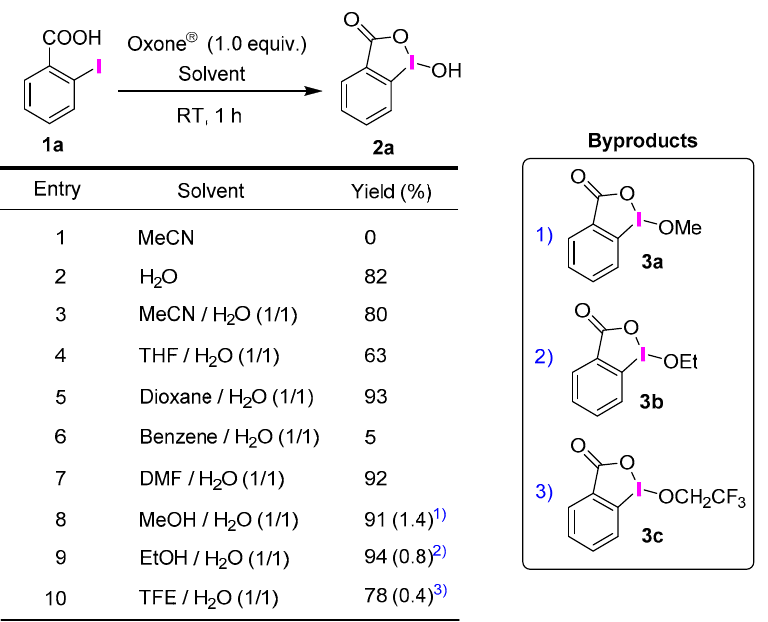
Figure 3. Solvent effect on the selective synthesis of IBA 2a from 2-IB 1a using Oxone ® .